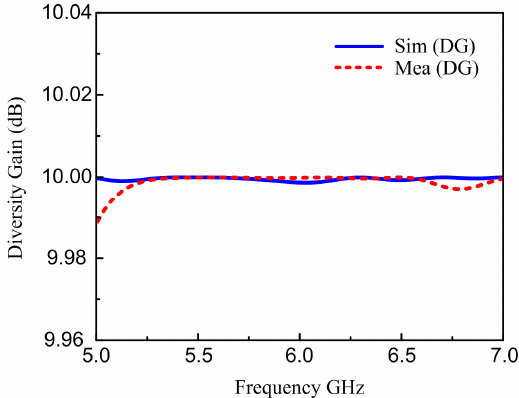
Figure 13. Simulated and measured diversity gain.